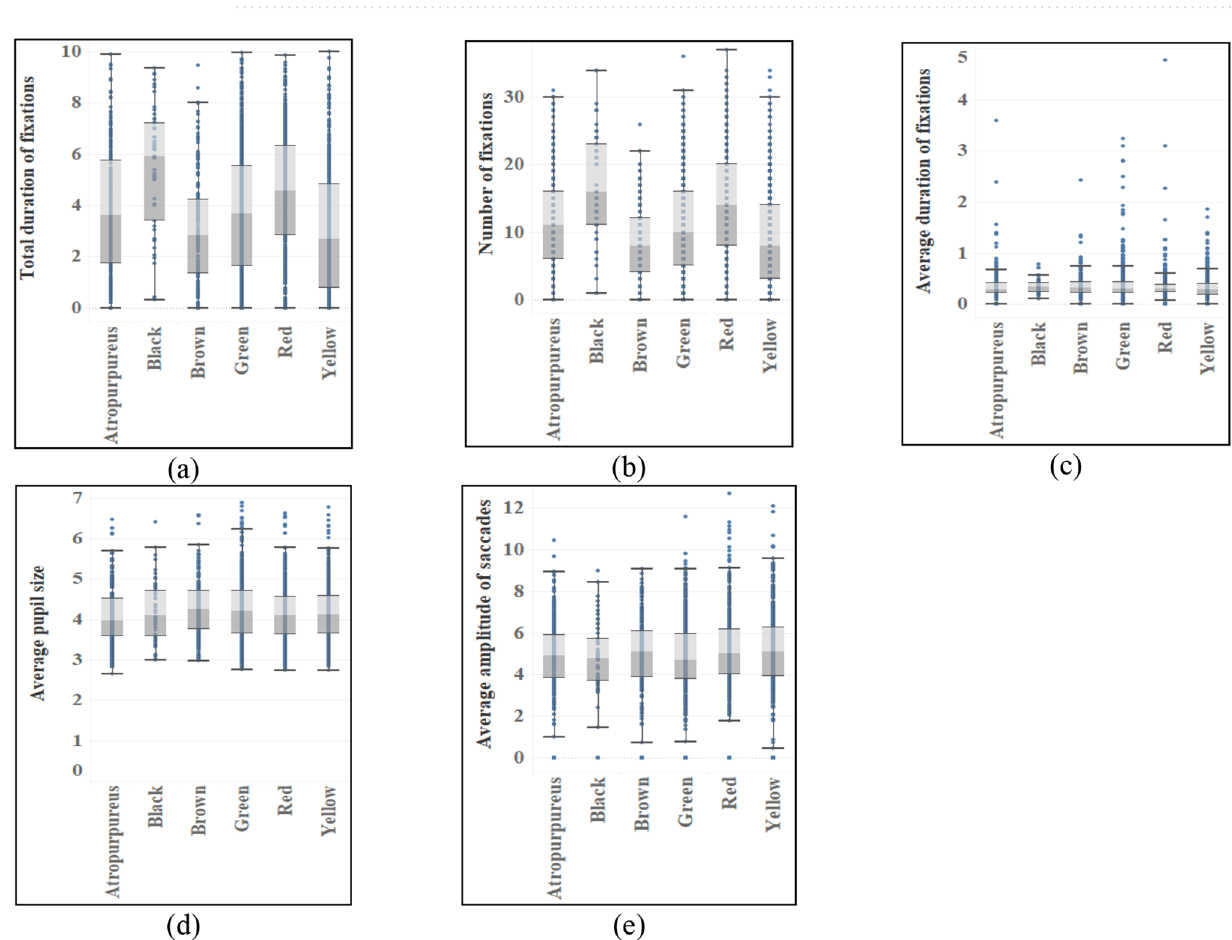
Figure 11. Eye movement indexes of different fruit